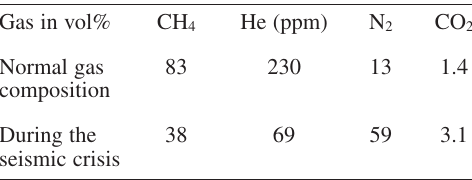
Table II. Gas composition in normal conditions and during the seismic